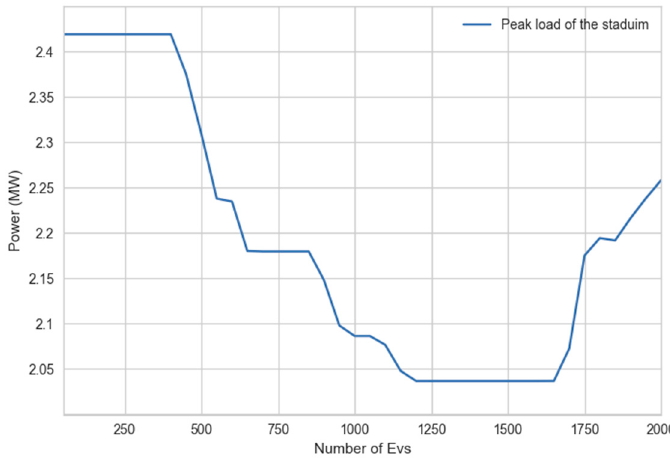
Figure 15. The maximum peak load of the stadium in Scenario 4 for different numbers of EVs. Note that the storage system is steered to best compensate for the load profile occurring in the entire feeders in this case.